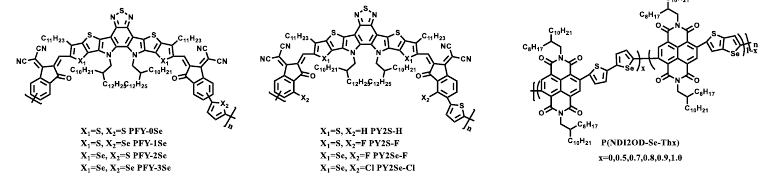
Figure 4. Polymer acceptors with selenophene.